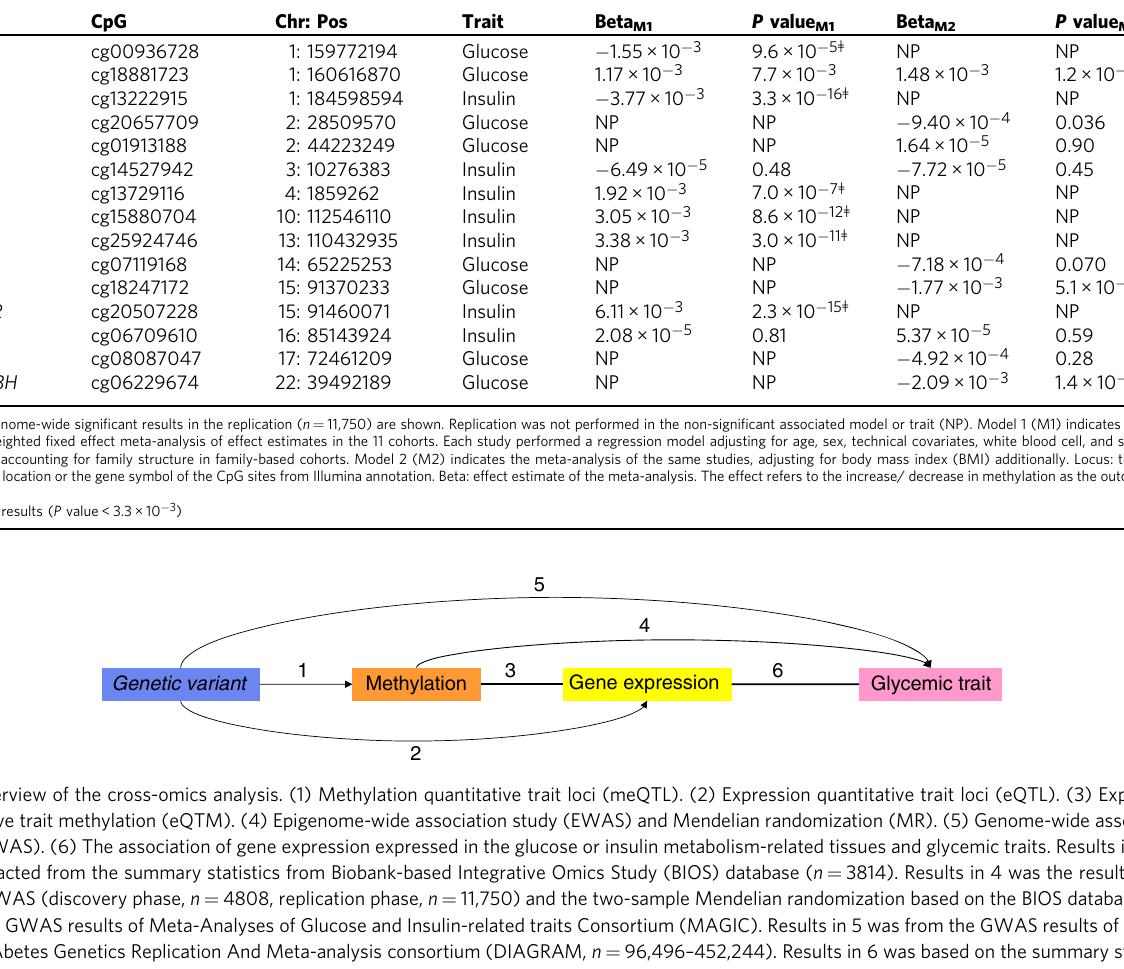
Table2 CpG sites associated with glycemic traits in replication Locus CpG